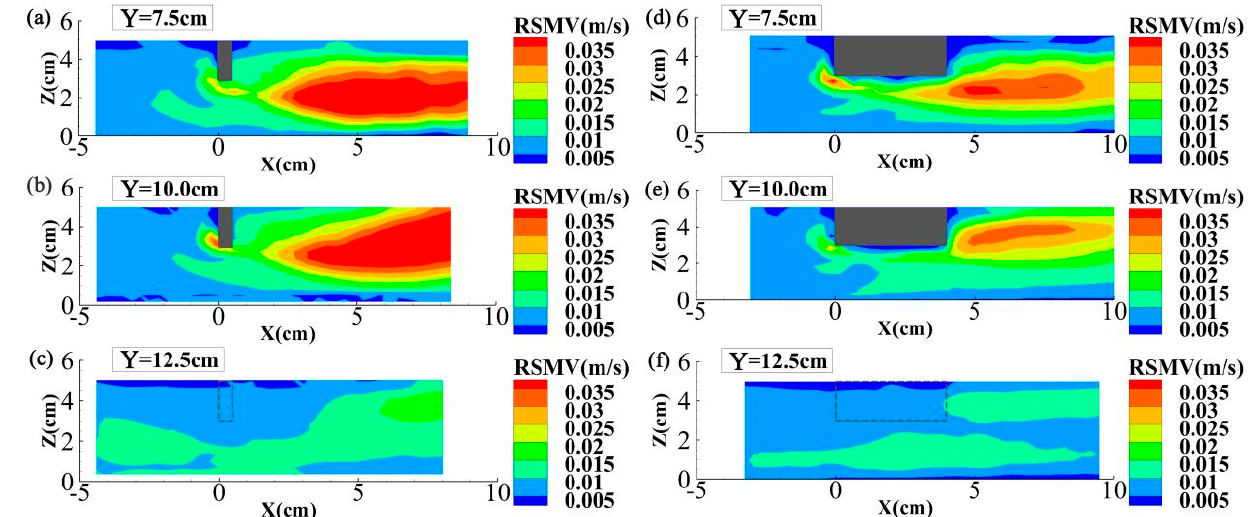
Figure 14. Distributions of velocity at longitudinal sections ( a ) Y = 7.5 cm, ( b ) Y = 10.0 cm, ( c ) Y = 12.5 cm in Case 7 (on the left) and at longitudinal sections ( d ) Y = 7.5 cm, ( e ) Y = 10.0 cm, ( f ) Y = 12.5 cm in Case 8 (on the right). The grey areas in subfigures ( a ), ( b ), ( d ) and ( e ) demonstrate the floating dike, and the dotted lines in subfigures ( c ) and ( f ) indicate the location of floating dike in the coor- dinate system.